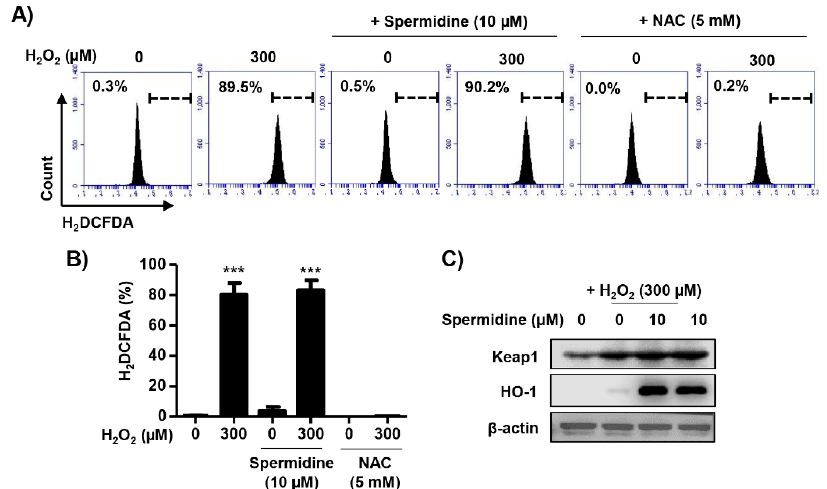
Figure 4. Effect of spermidine on intracellular reactive oxygen species (ROS) generation in H 2 O 2 - stimulated ARPE-19 cells. Cells were pre-treated with or without 10 µ M spermidine or 5 mM N-acetyl-L-cysteine (NAC) for 1 h, and then treated 300 µ M H 2 O 2 for 30 min. Subsequently, cells were stained with 10 μ M dichlorodihydrofluorescein diacetate (DCF-DA), and intracellular ROS generation was analyzed by flow cytometry. ( A ) Representative histograms. ( B ) DCF-DA fluorescence intensities were quantified. Data are expressed as the mean ± SD ( n = 3). *** p < 0.001 when compared to control. ( C ) Expression of Kelch-like ECH-associated protein 1 (Keap1) and heme oxygenase-1 (HO-1) were evaluated by Western blot analysis with whole cell lysates. Equal protein loading was confirmed by β -actin as an internal